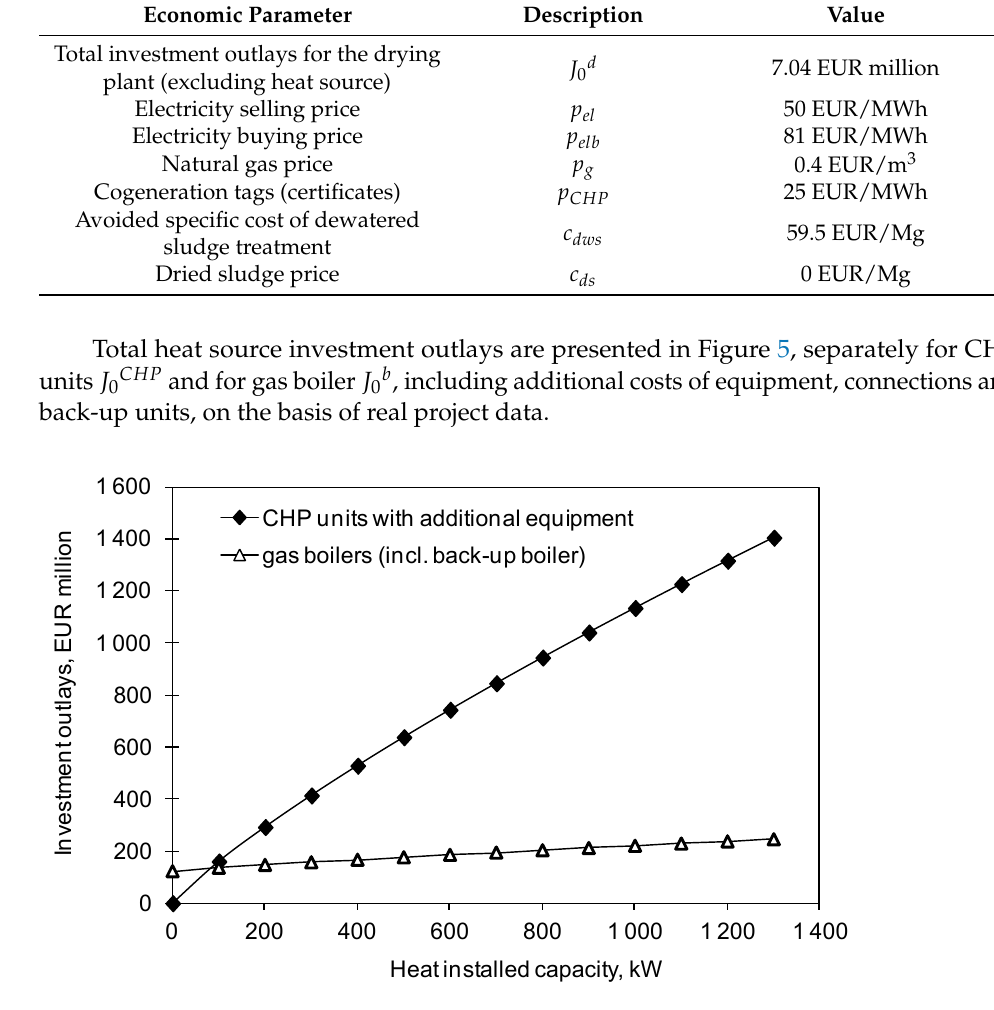
Figure 5. Investment cost of heat source units in function of the nominal heat capacity.